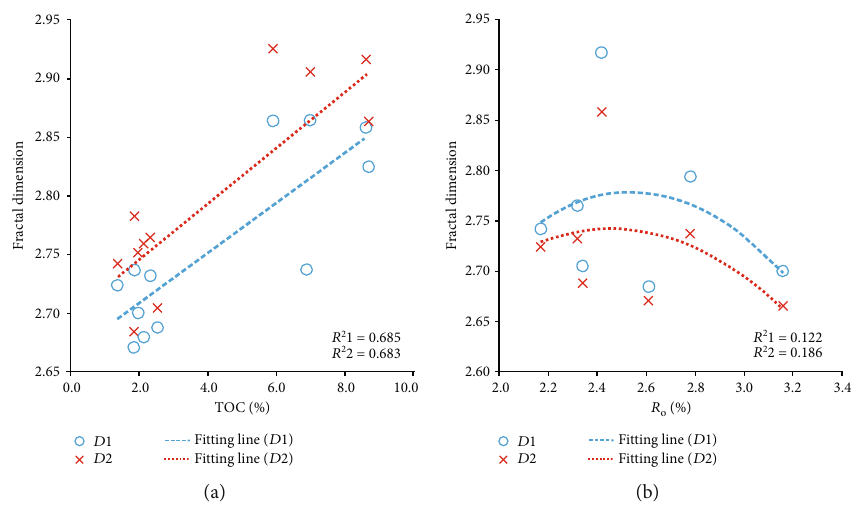
Figure 8: Correlation among fractal dimensions and geochemical parameters of Longtan shales.